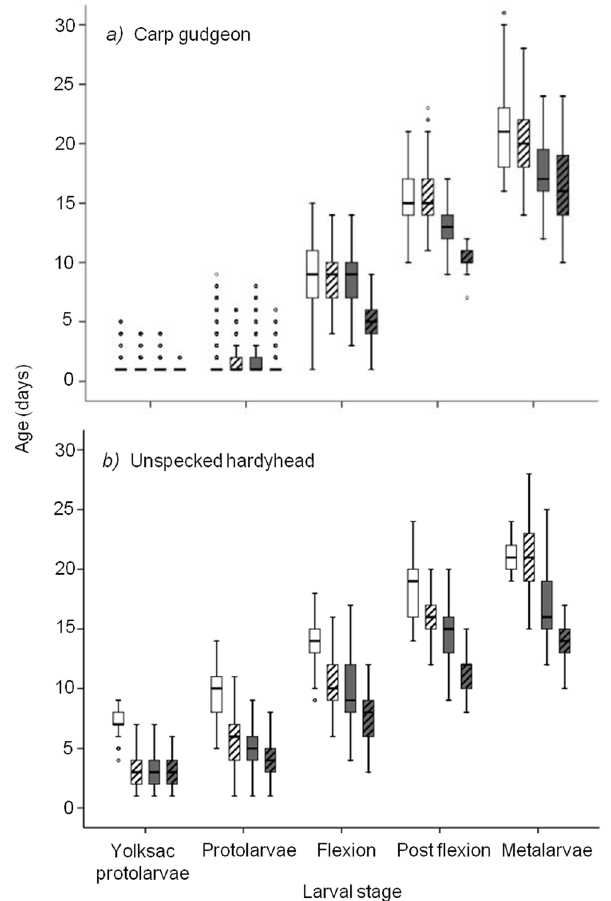
Figure 2. Monthly frequency box-plots of age (days) of each key developmental stage for a) carp gudgeon and b) unspecked hardyhead. October born larvae (white), November born larvae (white-striped), December born larvae (grey) and January born larvae (grey-striped).